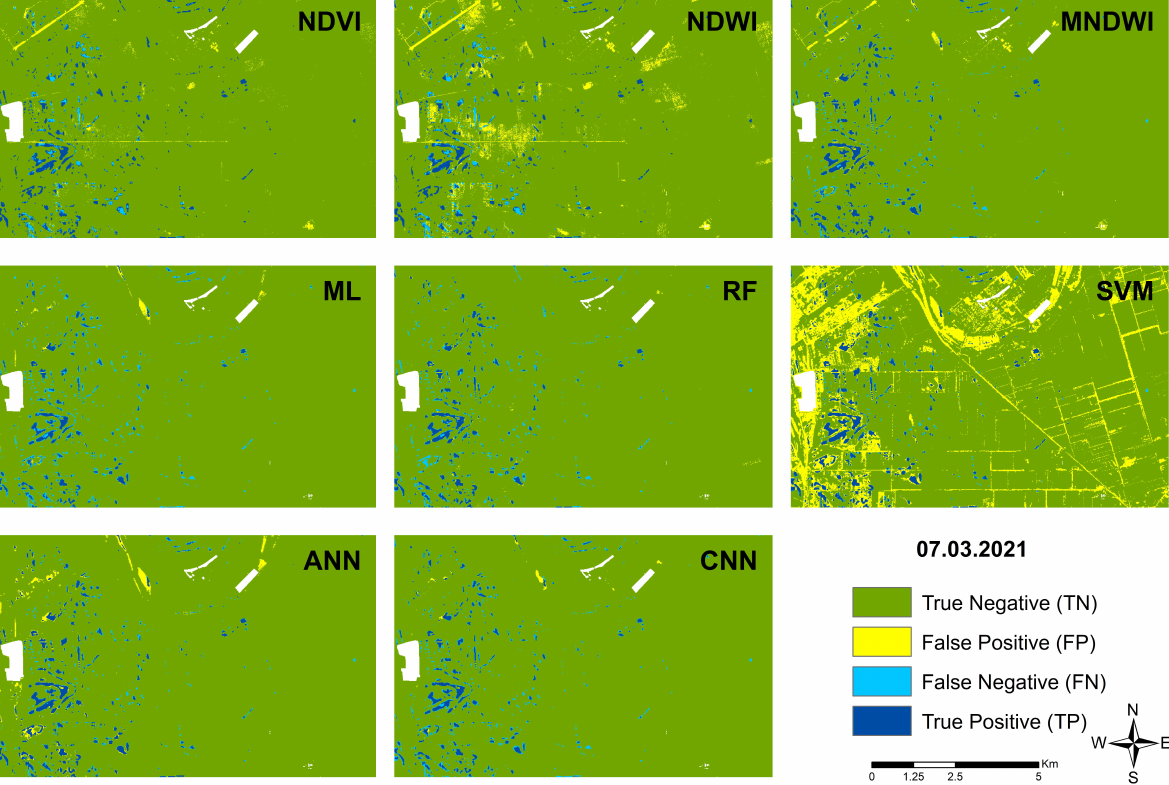
Figure 7. Results of the different classifications on 7 March 2021.